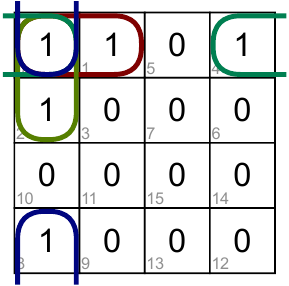
Figure 2. Fire Sensor